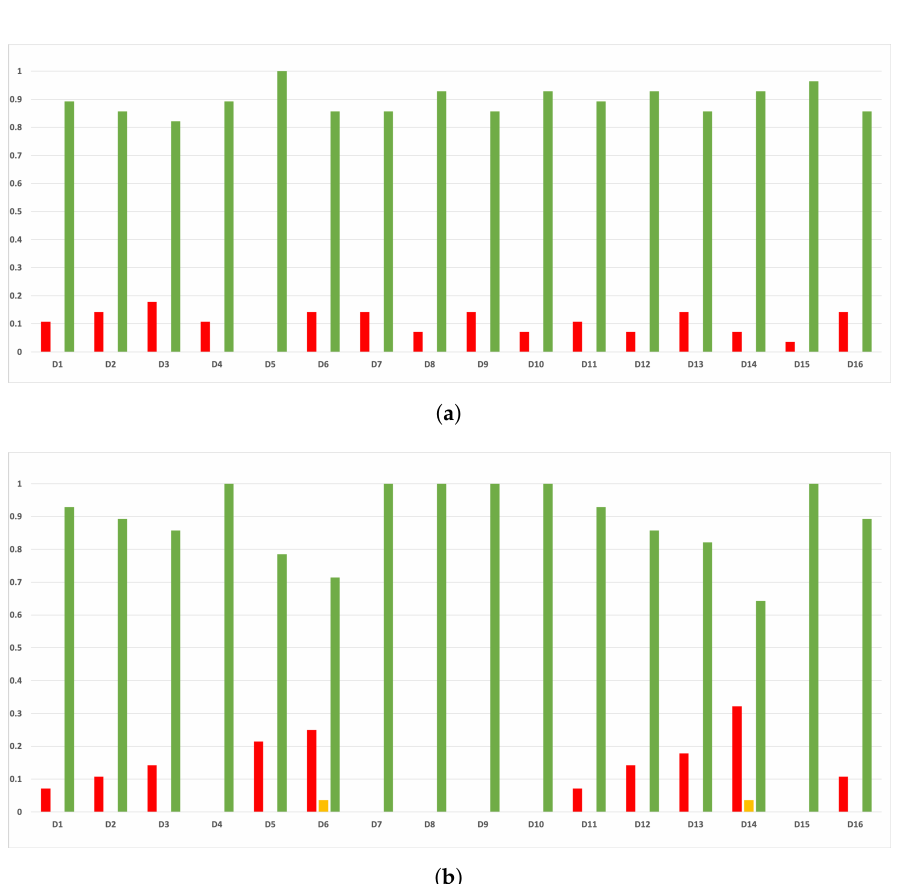
Figure A13. Consistency per dataset: rate of validity with the MCC and time complexity. ( a ) Rate of validity per dataset in DT. ( b ) Rate of validity per dataset in